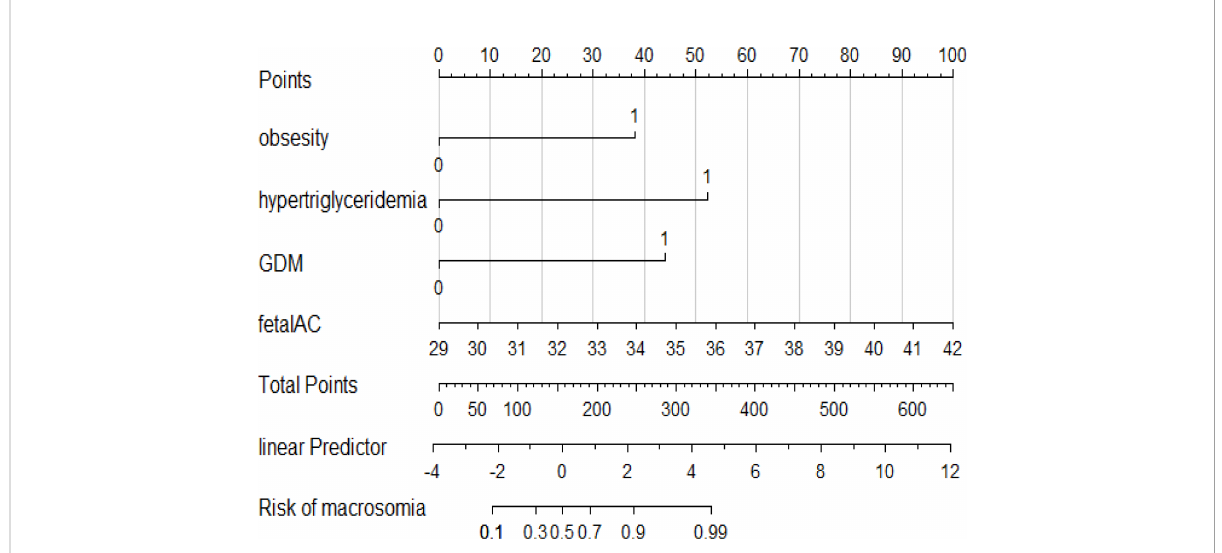
FIGURE 3 A nomogram prediction model of macrosomia. Four predictors were included: the prepregnancy obesity, hypertriglyceridemia, GDM, and fetal abdominal circumference. The score of each predictor were determined from each feature axis to the total points axis by following the vertical line. GDM, gestational diabetes mellitus; fetal AC, fetal abnormal circumference.